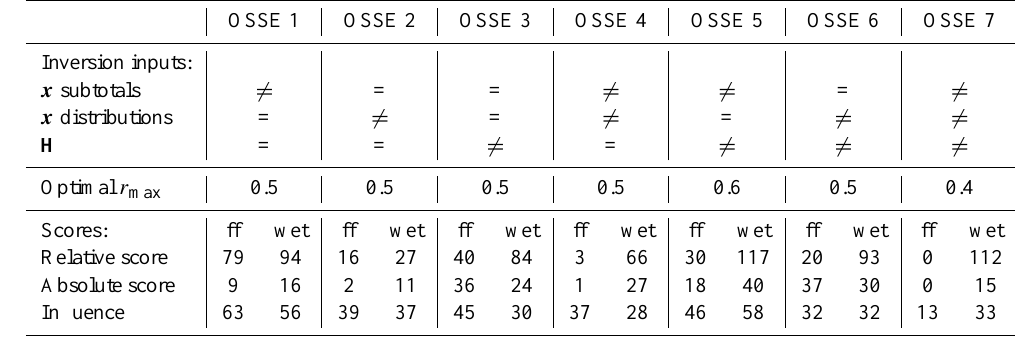
Table 1. OSSEs summary. Three parameters of the inversion (subtotal masses emitted per regions, emission distribution and transport) can be perturbed compared with the “truth”. The seven possible combinations are depicted by = and (cid:54)= signs for each parameter and each OSSE. Every OSSE is evaluated along the scores defined in Sect. 4.2. The scores are given in percentages for the best correlation threshold for grouping the state space components as presented in Sect. 4.2. The influence score must be as close to 100% as possible. The other two scores must be as small as possible. The regions are grouped along a correlation criterion r max (see Sect. 4.2); we present the scores only for r max with the best results. For OSSE 7, the scores are zeros for the fossil fuel regions because most of these regions were filtered out. The few remaining ones are very well